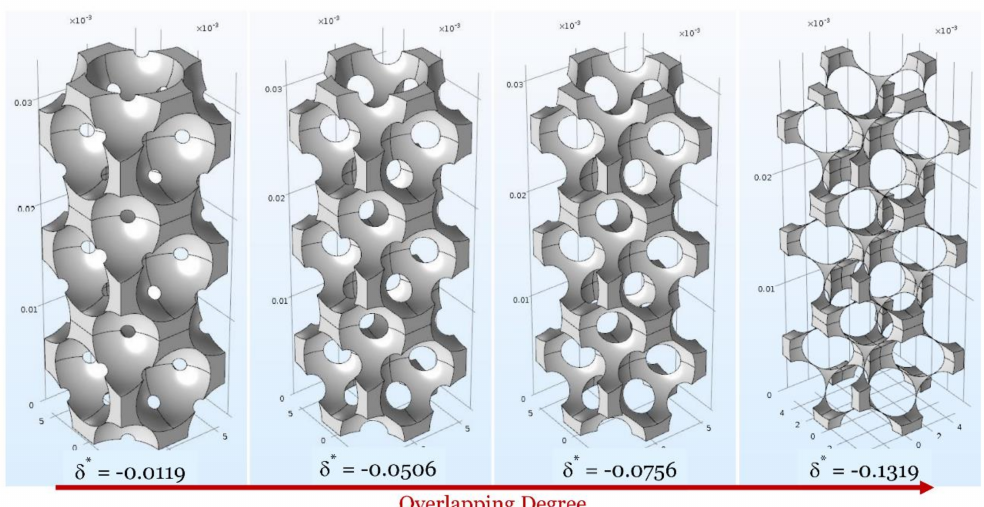
Figure 5. Morphology evolution of the FCC structure with increasing overlapping degree. The particular values of δ * are chosen just to better visualise the evolution of the